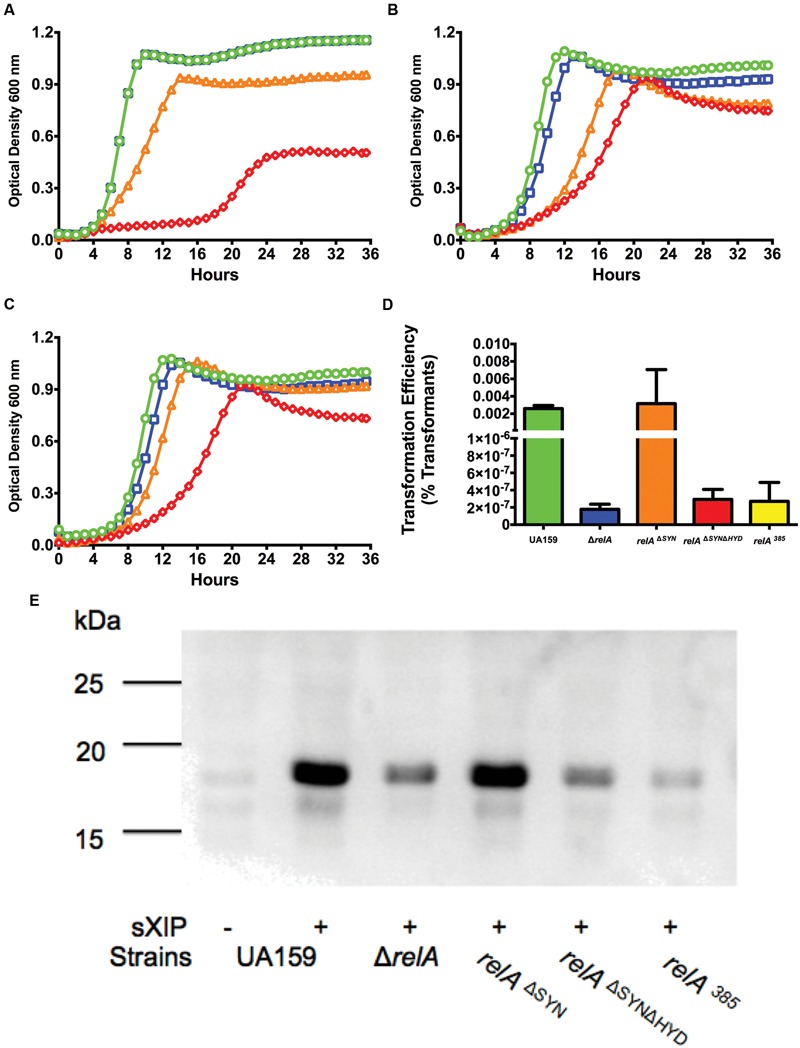
RelA hydrolase activity is critical for com gene expression. Growth curves of strains (A)
relAΔSY N, (B)
relAΔSY NΔHY D, and (C)
relA385 treated with different concentrations of sXIP. Bacterial cultures were grown in the chemically defined medium FMC containing 1% DMSO (●; green), or 0.2 μM (■; blue), 2 μM (▲; orange), or 20 μM (◆; red) sXIP. (D) Transformation efficiency of UA159 (green bar), ΔrelA (blue bar), relAΔSY N (orange bar), relAΔSY NΔHY D (red bar), and relA385 (yellow bar) in FMC medium after treatment with 2 μM sXIP. sXIP and purified pDL278 (SpR) were added when OD600
nm reached 0.2. Cultures were diluted and plated, and transformation efficiency was calculated as detailed in Figure 3. Data are the average of three individual experiments conducted in triplicate. (E) Detection of ComX in the relA mutant grown in FMC with either 1% DMSO (-) or 2 μM sXIP (+) added at OD600
nm = 0.2 and then incubated for 1 h. ComX was detected as above, using the same molecular mass standards (in kDa).